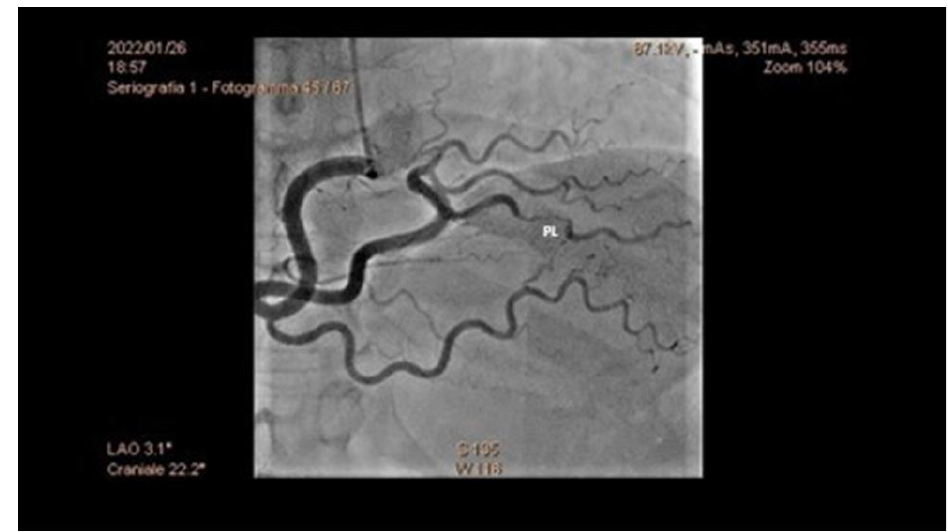
Figure 1. Coronary angiography of a 43-year-old woman, showing SCAD of the postero-lateral artery (PL). SCAD: spontaneous coronary artery dissection.